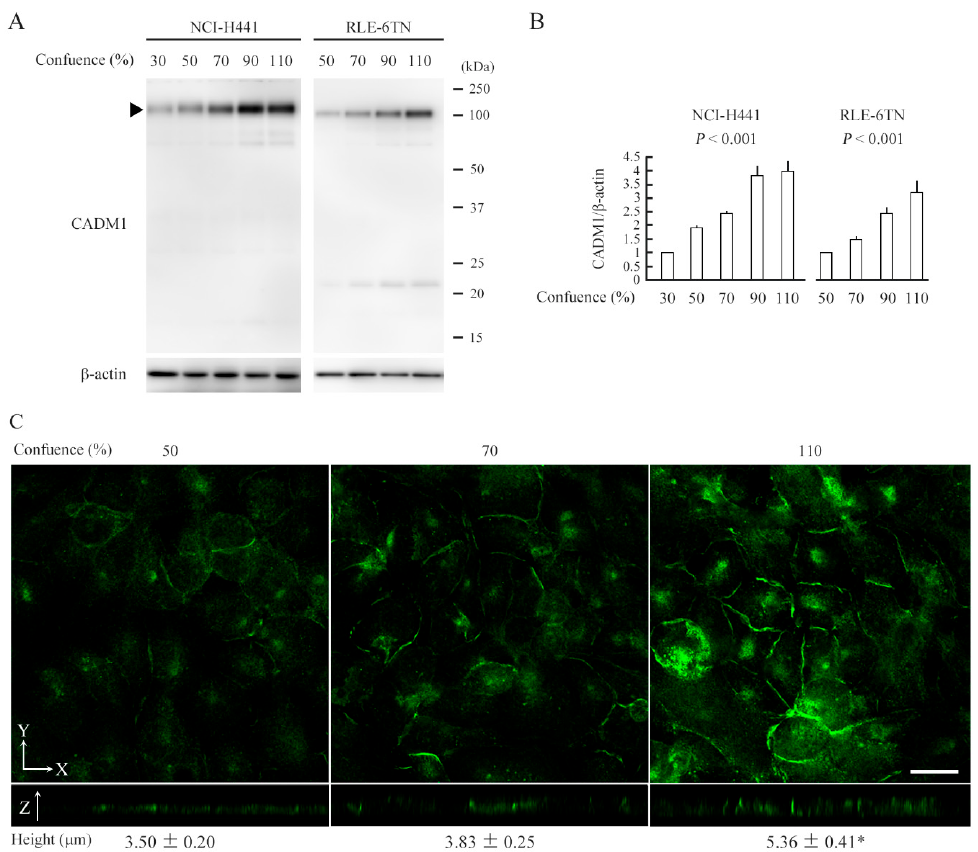
Figure 1. NCI-H441 and RLE-6TN cells express more CADM1 and grow in height as they crowd. NCI-H441 and RLE-6TN cells were cultured on a semipermeable membrane in 12-well plates. The cell lysates were extracted at indicated confluence and were blotted with the antibodies indicated ( A ). Intensities of the immunoreactive bands for CADM1 (the full-length form depicted by an arrowhead) and β -actin were measured densitometrically. The mean ratios of CADM1 to β -actin and their standard deviations were calculated from the data obtained in triplicate experiments. Statistical differences were analyzed by one-way ANOVA, and p -values are shown ( B ). NCI-H441 cells at indicated confluence were stained green with CADM1 immunofluorescence using the anti- C -terminal antibody. The means and standard deviations of cell heights were calculated from the data obtained in triplicate experiments and were statistically analyzed by one-way ANOVA ( C ). * p < 0.001 by Bonferroni correction when compared with 70% confluence cultures ( C ). Scale bar = 10 µm. Statistic data are shown in detail in Supplementary Table S2.